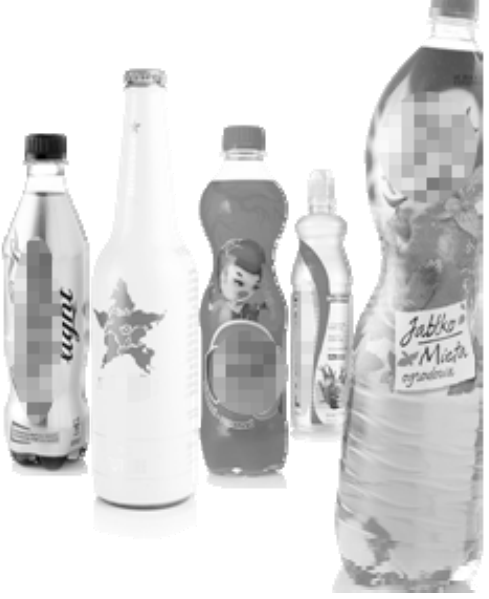
Figure 1. Sample packaging with heat-shrink film labels. (Adapted from resources of Masterpress S.A.).